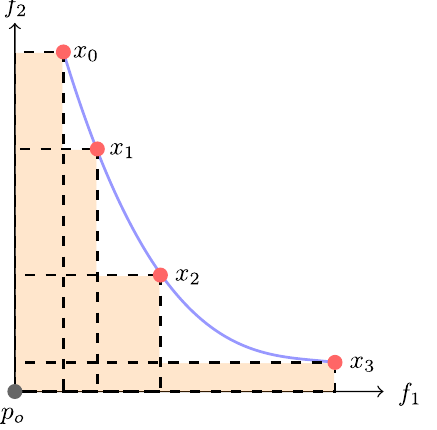
FIG. 3. The hypervolume for a two-objective optimization problem corresponds to the shaded area formed by the dashed rectangles spanned by all points on the Pareto front and an arbitrary selected origin p . o